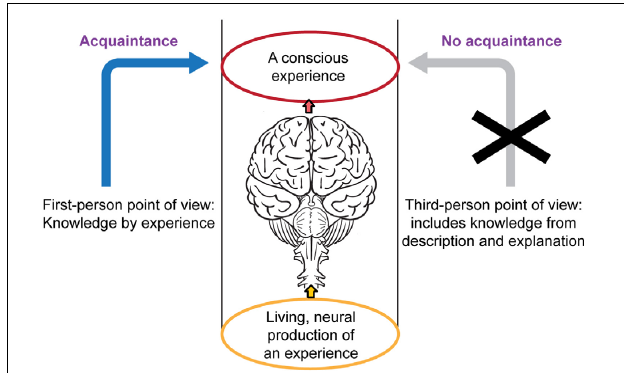
FIGURE 6 | Some kinds of knowledge can only be obtained by experience. Knowing is of two types, experiential (left) and descriptive (right). An observer cannot fully know an experience (X at the right) without directly experiencing it, even though the experience is generated physically by neurons in a living brain (center column). The distinction here between first- and third- person points of view does not entail dualism between the brain and the mind or require a “non-physical” explanation for phenomenal consciousness. Also see Feinberg and Mallatt (2018b). Figure © Mount Sinai School of